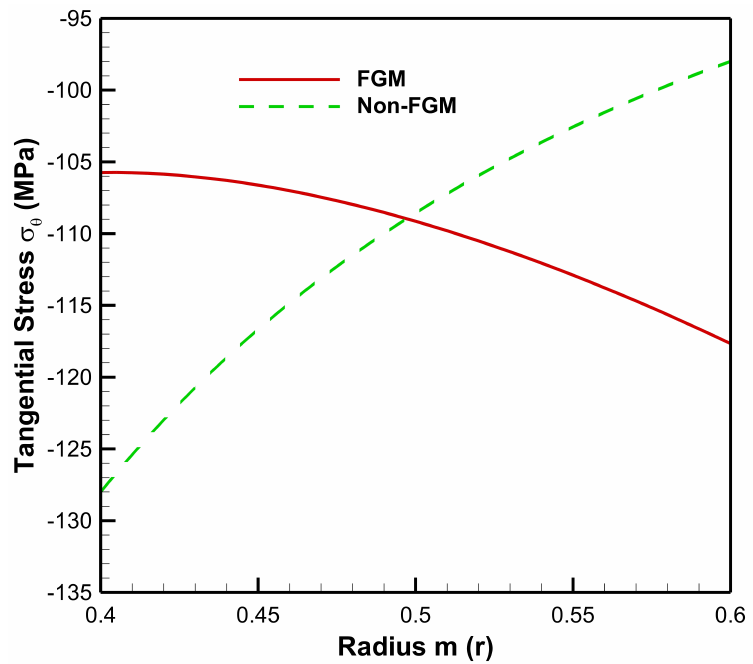
Figure 13. Tangential Stress along the radius of the cylinder under internal pressure, P a = 20 MPa and external pressure, P b = 50 MPa.